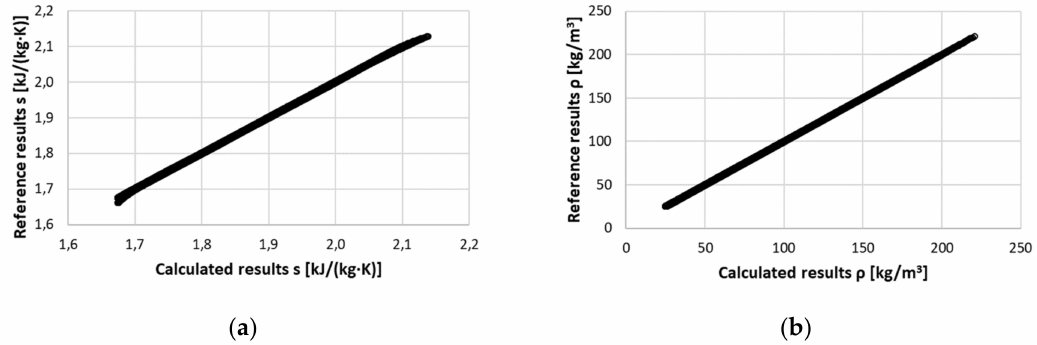
Figure 4. Comparison of the reference results and calculated results for superheated vapour: ( a ) Specific entropy; ( b ) Density.